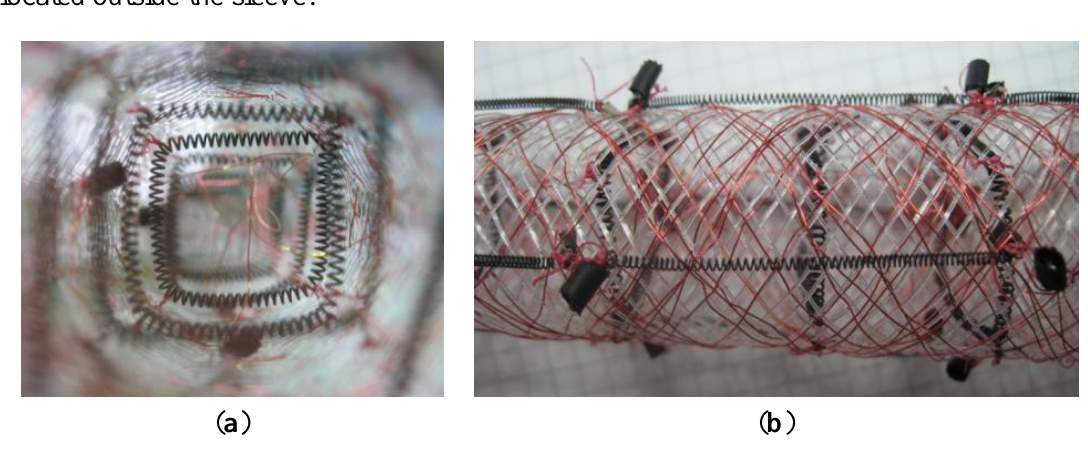
Figure 5. Soft actuation for the octopus-like robotic arm: ( a ) the transverse SMA springs are housed inside the braided sleeve and connected to it; ( b ) the longitudinal springs are located outside the